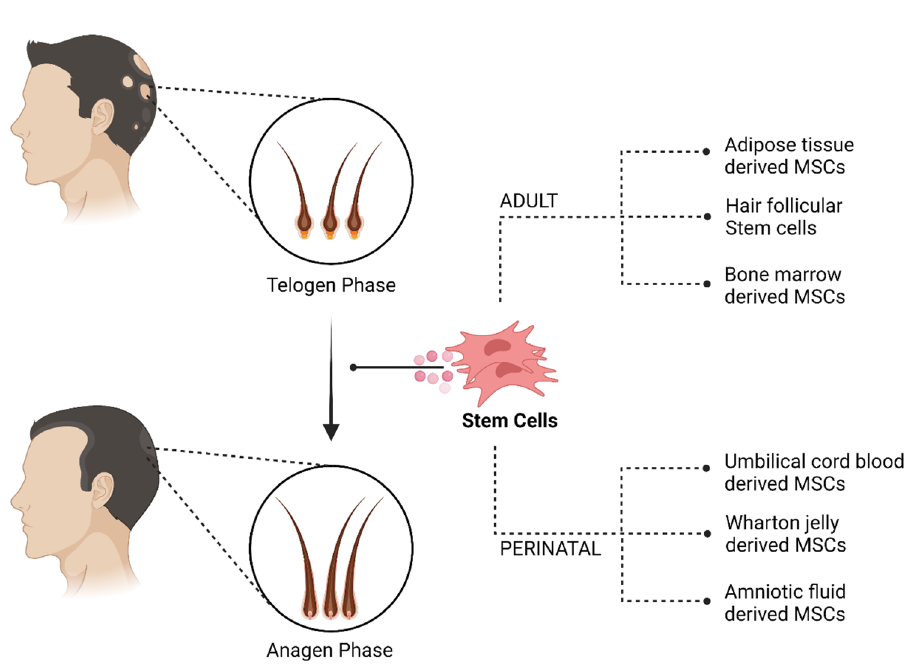
Figure 2. Cellular therapy for non-scarring alopecia. Created with BioRender.com (accessed on 1 March 2022).